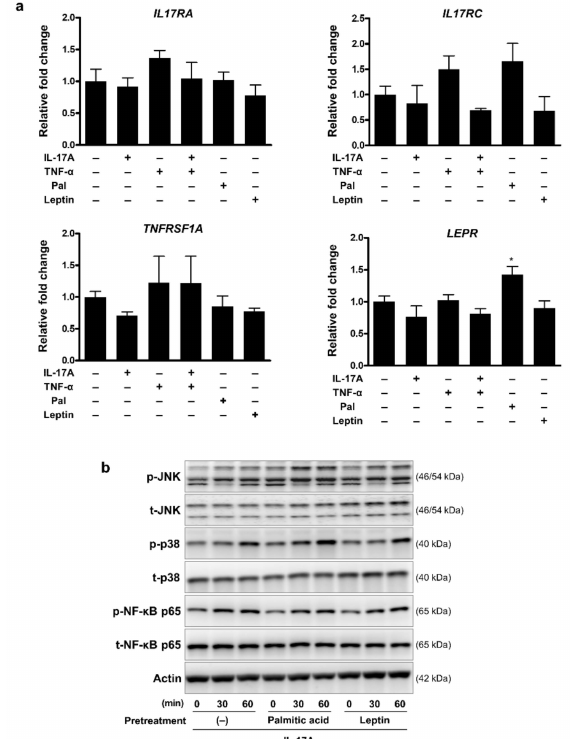
Figure 6. Effects of palmitic acid and leptin on receptors and signaling pathways in epidermal keratinocytes: ( a ) mRNA expression of receptors. NHEKs were treated with the indicated cytokines and palmitic acid. The mRNA expression levels of each receptor were determined 24 h after the indicated stimulation. Values are presented as the mean ± standard deviation; * p < 0.05, compared to non-stimulated cells. ( b ) Representative images of Western blot analysis. NHEKs were pretreated with palmitic acid (100 µ M) or leptin (100 ng/mL) for 2 h, and then treated with IL-17A (30 ng/mL) for the indicated time. Phospho- or total-JNK, p38, and NF- κ B p65 were detected using specific antibodies. Actin was used as a loading